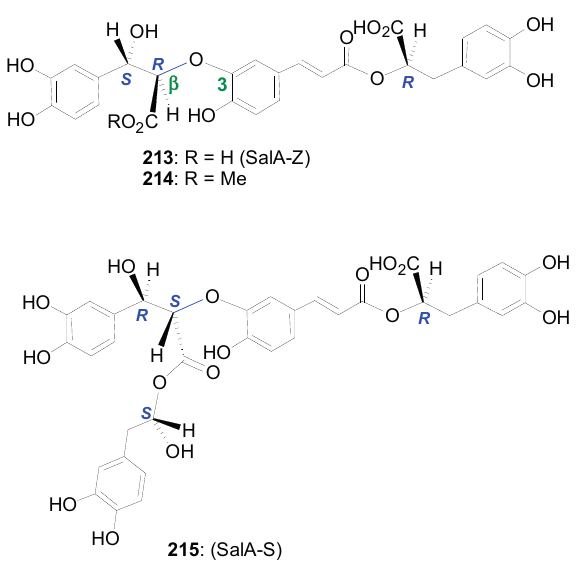
Figure 16. The structures of SalA-Z and SalA-S and of the methyl ester 214 of the